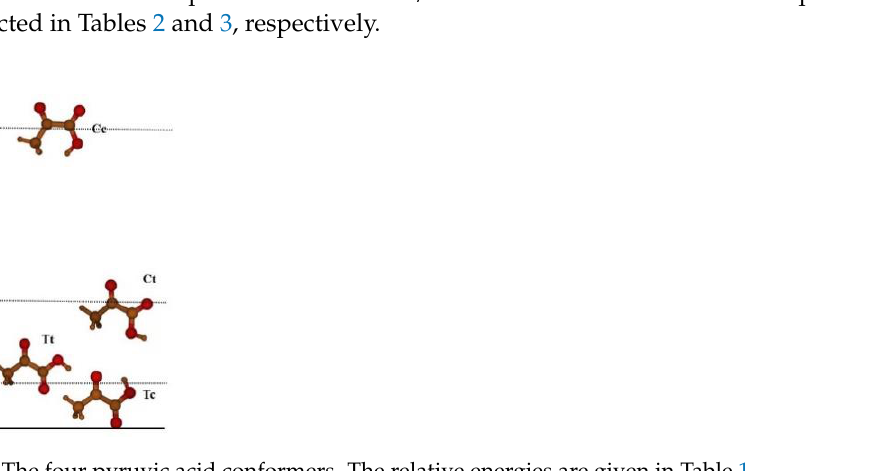
Table 1. CCSD(T)-F12/AVTZ-F12 relative energies (E, E ZPVE , in cm −1 ), internal rotation barriers (V 3 , V OH , V CC in cm −1 ), and equilibrium rotational constants (in MHz); MP2/AVTZ dipole moment (in D) of pyruvic acid.